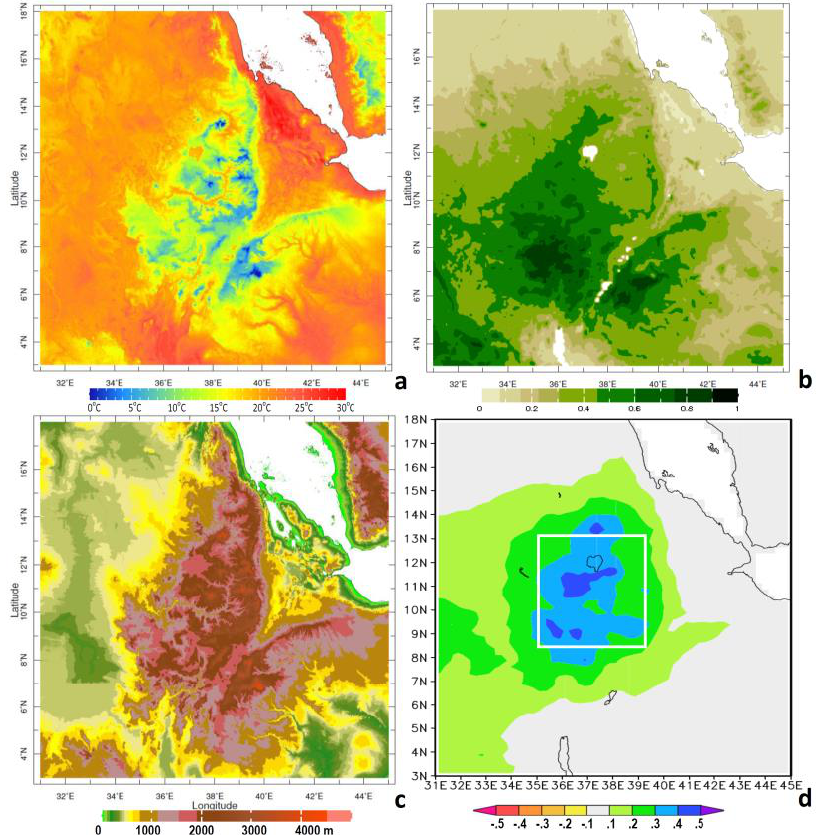
Figure 1. ( a ) Mean nocturnal land surface T and ( b ) NDVI vegetation color fraction of the Ethiopian highlands averaged 2000–2014. ( c ) Topographic map of the study area and ( d ) Empirical Orthogonal Functions (EOF) loading pattern of cenTrends 1st mode P and box for the extraction of time series. Table 2. Categorization of sub-seasonal rainfall percentages (yellow-least, blue-most). LEAST Early